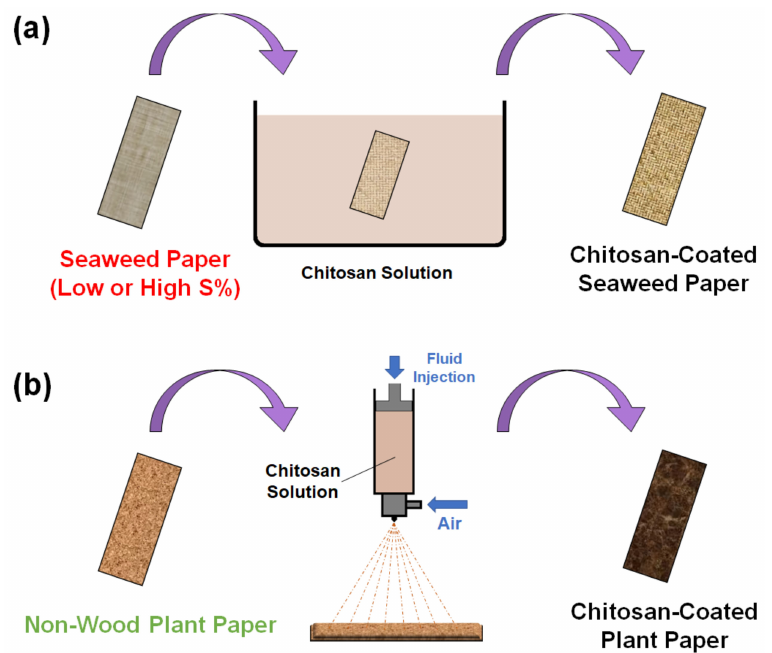
Figure 1. Chitosan was coated on ( a ) seaweed paper by dip coating or ( b ) plant paper by spray coating.